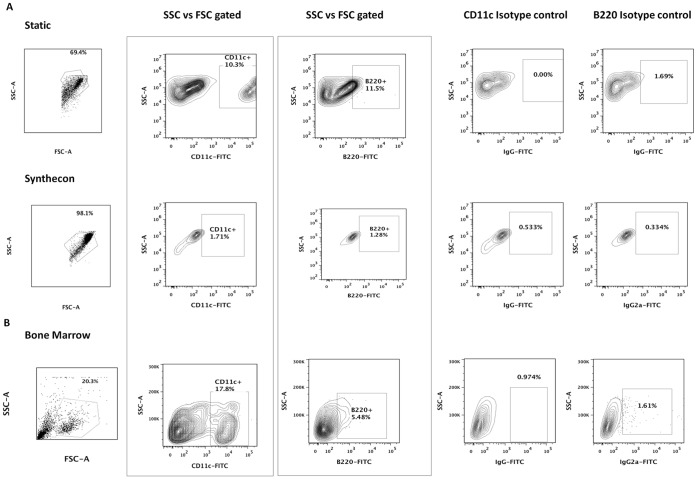
Functionality of various LKS cells.Hematopoietic differentiation of in-vitro and in-vivo derived Lin-ckit+Sca-1+ cells. A) Lin-ckit+Sca-1+ in-vitro derived ESCs from Static and Dynamic (Synthecon) culture conditions, as well as B)
in-vivo isolated LKS cells from Bone marrow (BM) were cultured for 7 days in the presence of GM-CSF, IL-4 and IL3. Approximately 10.3% of Static-derived cells (gated on FSC-A and SSC-A) are CD11c+ (Dendritic-like cells) and about 11.5% express B220+ (B cell-like progenitors). No significant expression of CD11c or B220 in Synthecon-derived cells is observed following differentiation. As expected, Lin-ckit+Sca-1+ BM cells also differentiate into CD11c and B220+ hematopoietic progenitors.